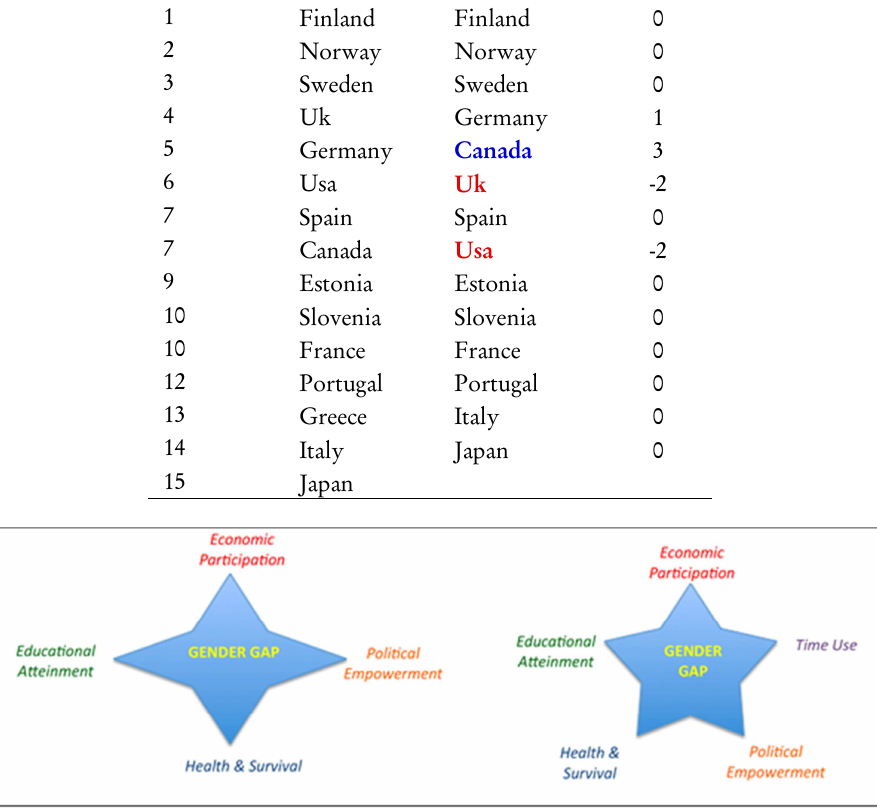
Figure 1 – Representation of GGGI as computed by 4-dimensions methodology and by 5-